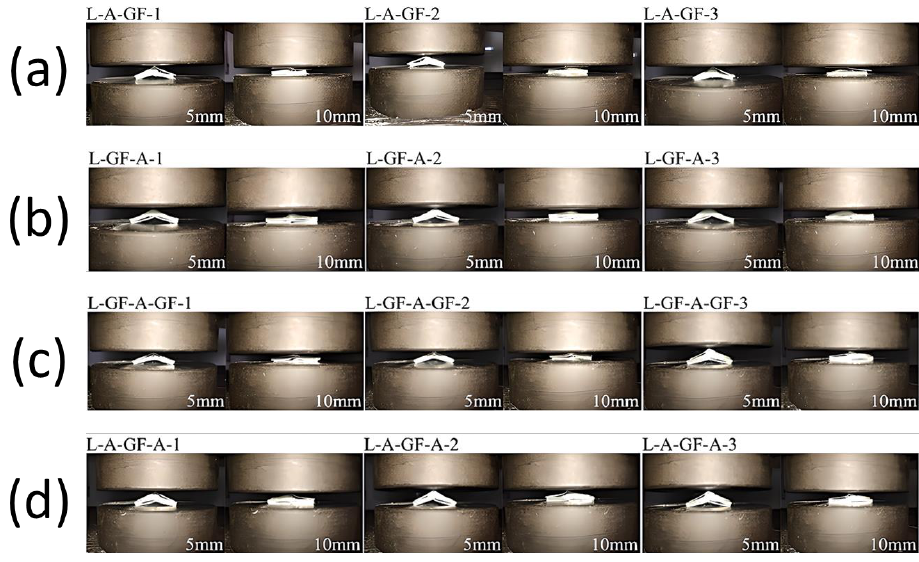
Figure 13. Lateral deformation history of ( a ) AGF, ( b ) GFA, ( c ) GFAGF, ( d )